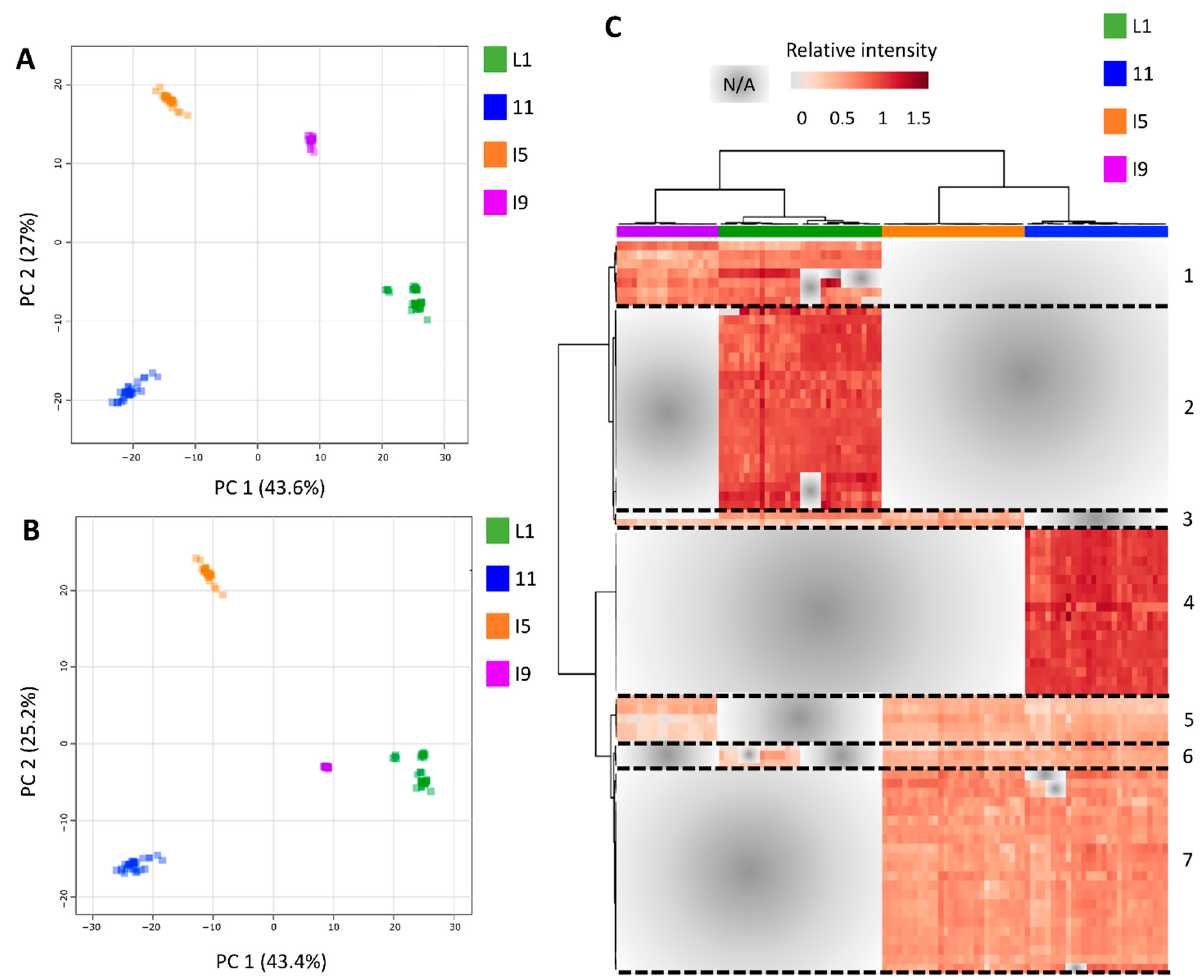
Figure 5. Discriminant models of the metabolomics data demonstrated that most of the variation within metabolomics profiles is attributed to the differences between the distinct anatomical tissues. ( A ) PCA and ( B ) PLS − DA models generated from dry weight (DW) normalized and log10 transformed metabolomics data, combining all tissues (L1, I1, I5, and I9), sampling points (C1, C2, C3, and C4) and experimental fields (F1 and F2) (component 1 Q2 = 0.98761, R2 = 0.9882 and component 2 Q2 = 0.99452, R2 = 0.99516). ( C ) Heatmap representation of the 79 main metabolites responsible for the separations (VIP scores ≥ 1.0 from PLS-DA analysis). The list of the 79 metabolites names is available in the Table S16.